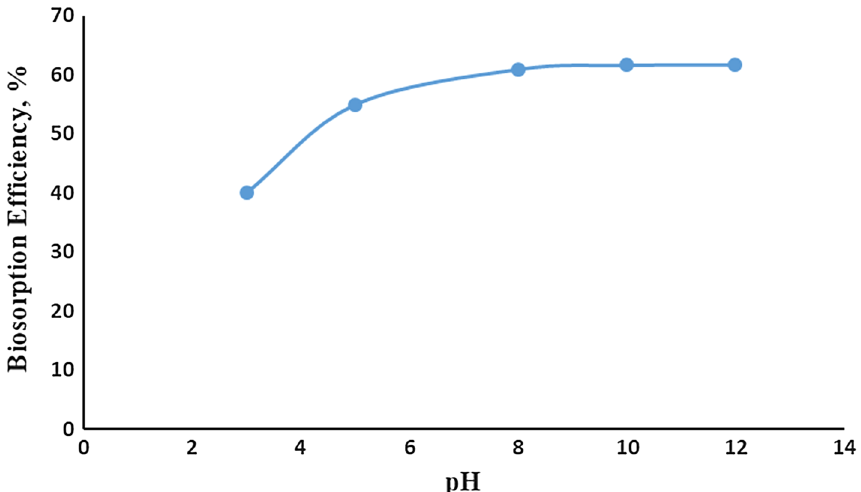
Fig. 5 The effect of pH on the biosorption (298 K, 70 ppm initial concentration of MB)